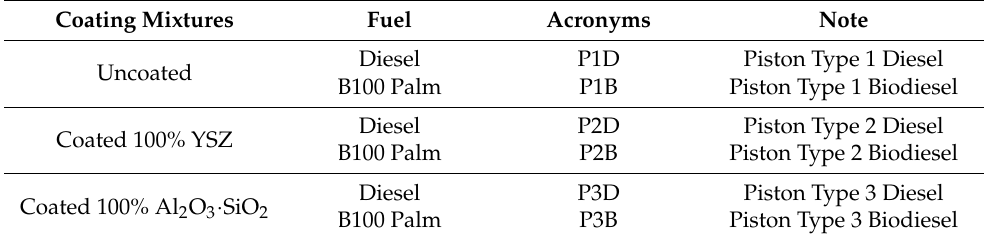
Table 5. List of Thermal Barrier Coating Mixtures. Coating Mixtures